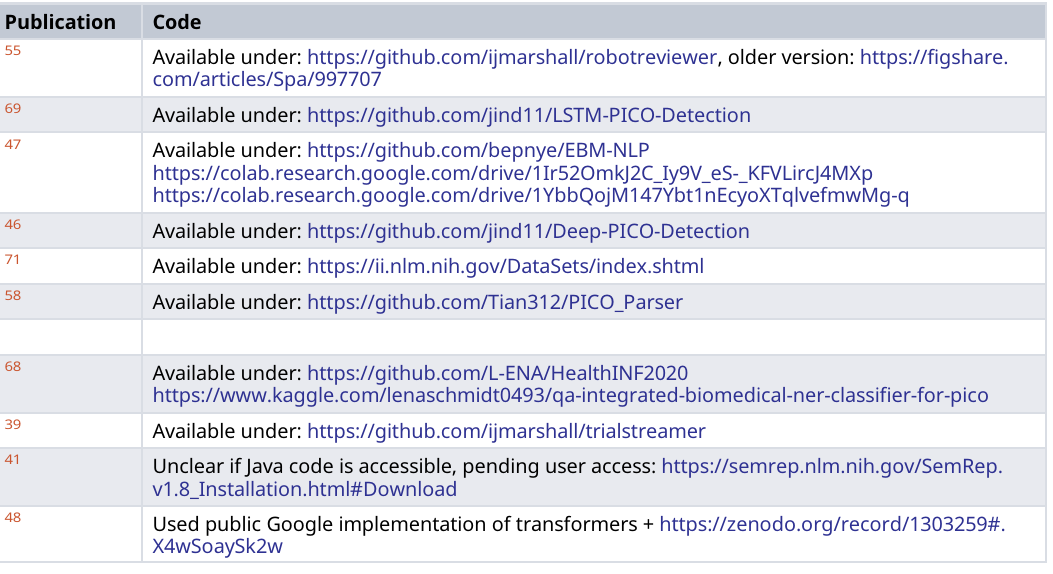
Table 2. Repositories containing source code for the included